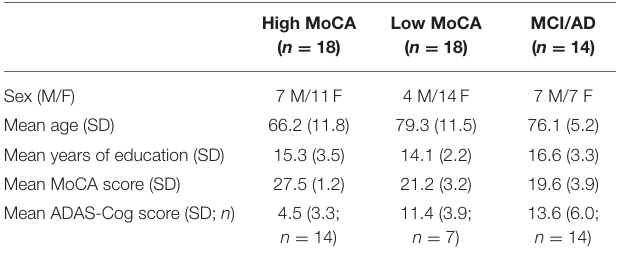
TABLE 1 | Baseline demographic information and clinical scores for each of the study